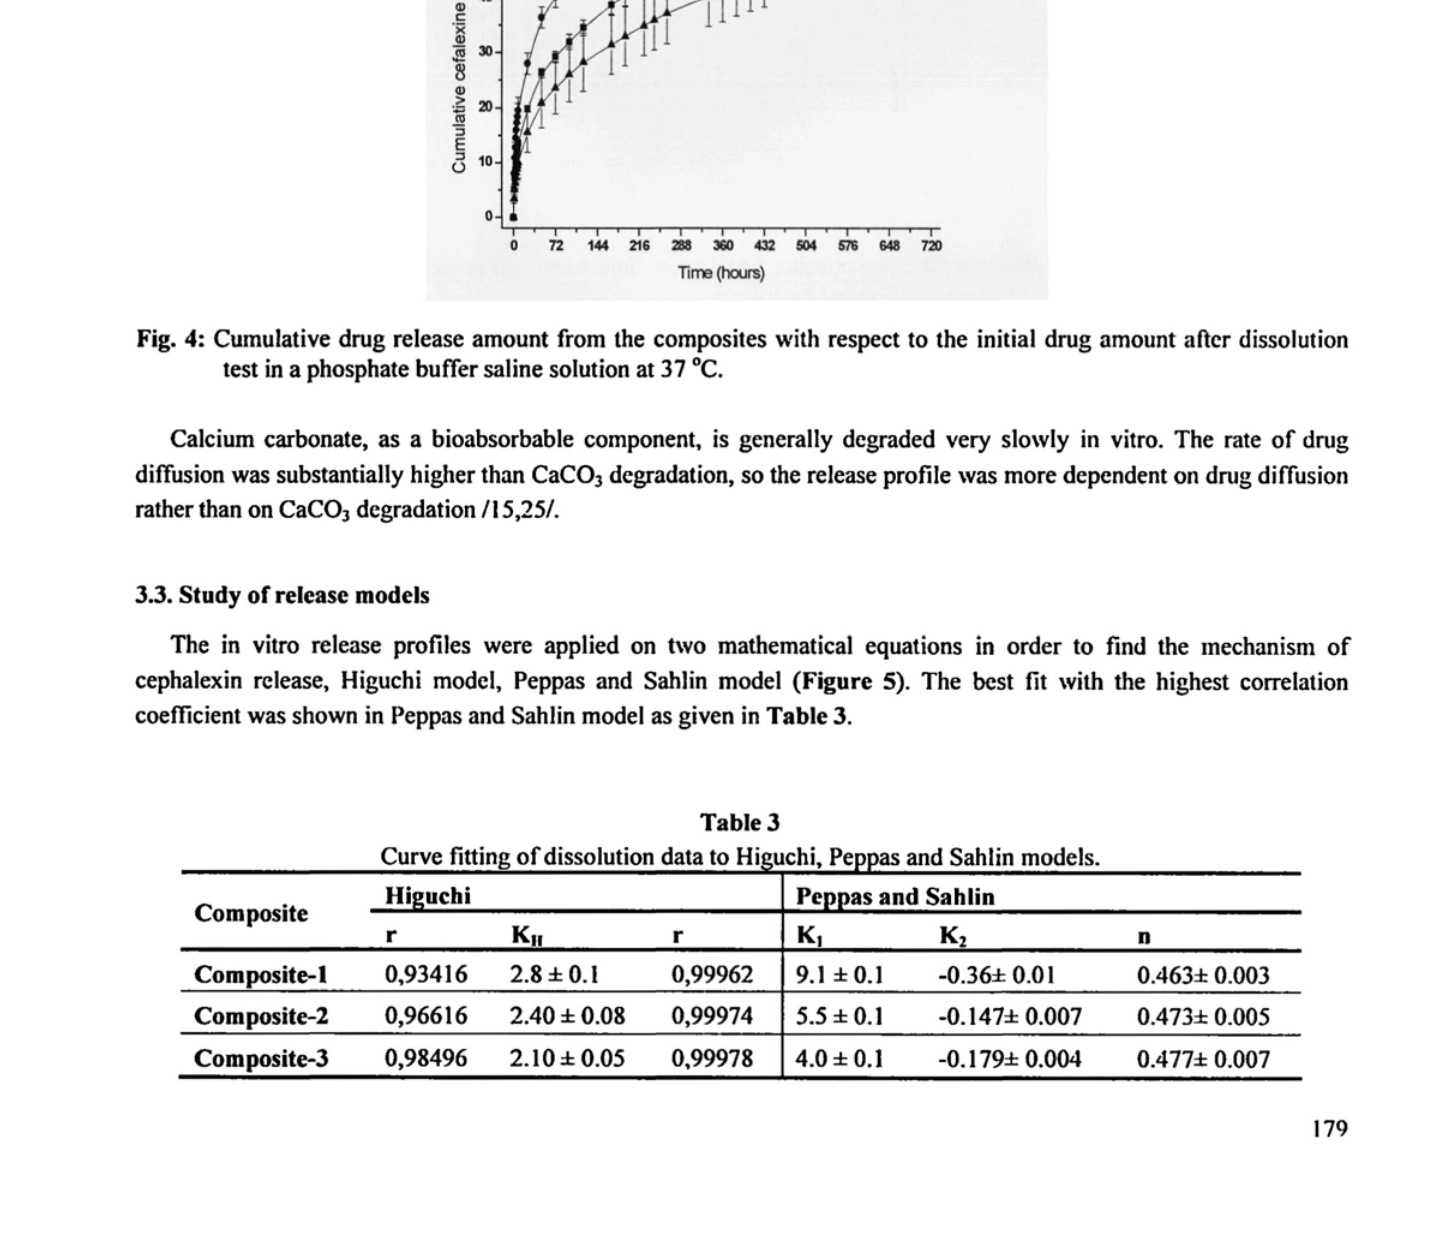
Curve fitting of dissolution data to Higuchi, Peppas and Sahlin